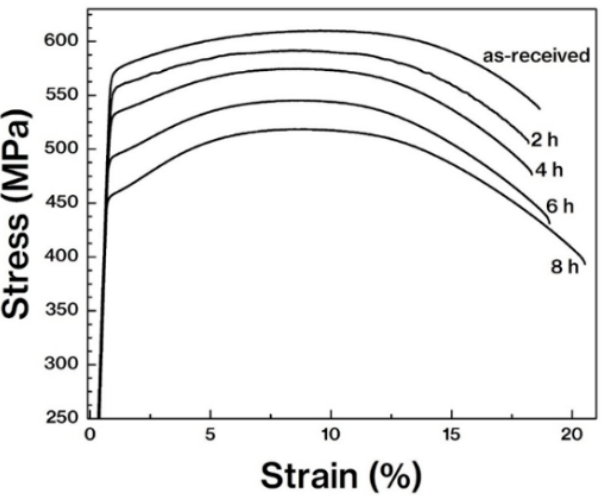
Figure 1. The graph of creep strain vs. time under various applied stress levels. The room temperature tensile test was performed at a strain rate of 10 − 4 s − 1 . Figure 2 depicts the stress vs strain curves for the pure aged (2-8 h) and as-received specimens. It can be observed that, with increasing ageing time, the elongation increased but the flow stress decreased. The as-received specimen possessed the maximum yield strength at around 574 MPa and ultimate tensile strength at around 612 MPa, and both of the strength decreased with increasing ageing time.